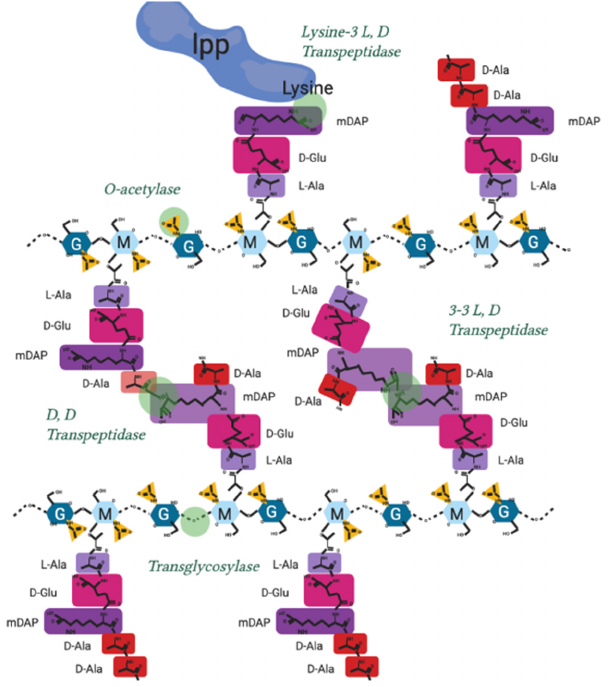
Figure A2. Peptidoglycan crosslinking sites and activity in Gram-negatives. Peptidoglycan molecular structure, with sites of crosslinking actions and enzyme nomenclature labelled. Peptidoglycan is also polymerised and modified by a series of crosslinking enzymes such as the penicillin-binding proteins (PBPs) or L, D transpeptidases at different points in the bacterial cell cycle as well as after stress events. The modification sites shown in Figure A2 are the points of peptidoglycan crosslinking and attachment known in Gram- negative bacterial species [9,47,88]. Their individual activities are elaborated in Table A2.